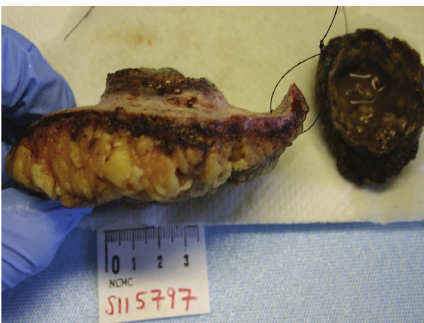
Figure 3: Slide showing giant malignant cells (arrow) in an inflammatory background (H&E) 40x.